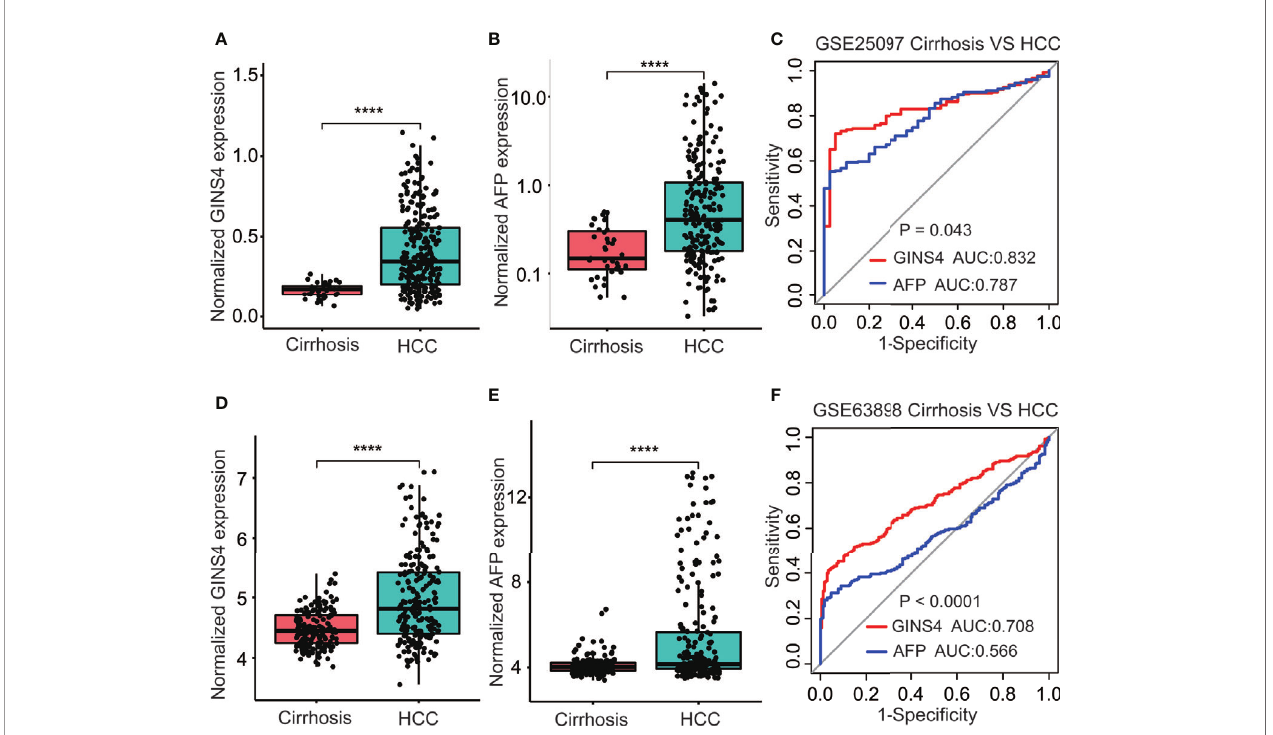
FIGURE 6 | GINS4 harbors a great performance to differentiate HCC from liver cirrhosis. GINS4 mRNA level between liver cirrhosis and HCC samples from (A) GSE25097 and (D) GSE63898. AFP mRNA level between liver cirrhosis and HCC samples from (B) GSE25097 and (E) GSE63898. ROC curve demonstrates the discriminative ef fi ciency of GINS4 and AFP between liver cirrhosis and HCC samples from (C) GSE25097 and (F) GSE63898. (****P < 0.0001). ROC, the receiver operating